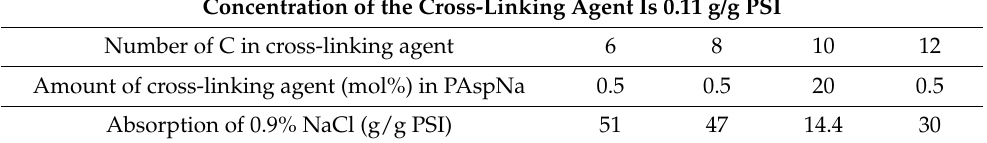
Table 2. Amount of cross-linking agent (mol%) in PAspNa and saltwater absorption when the concentration of the cross-linking agent was 0.11 g/g